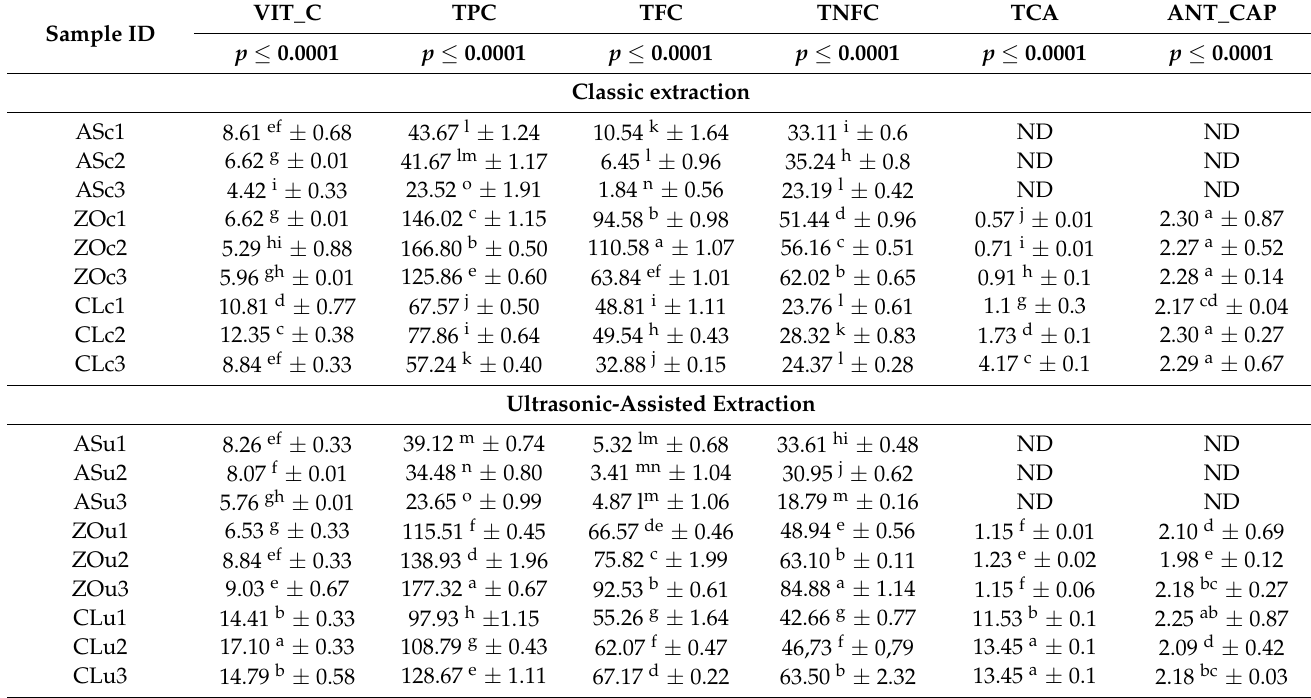
Table 3. Specialized metabolites content, antioxidant capacity of spice